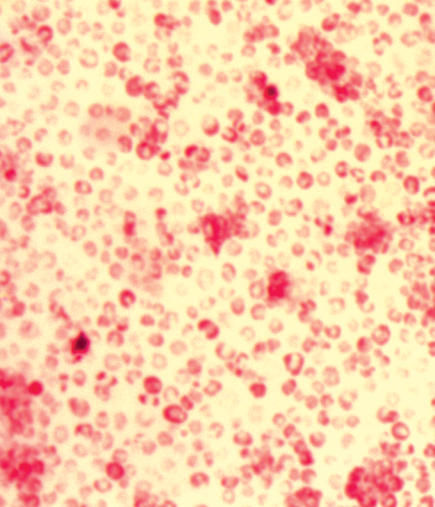
HIV-infected monocyte-derived macrophages show lipid accumulation (lipids are stained red) in HIV-infected cells. (Image: Zahedi Mujawar)